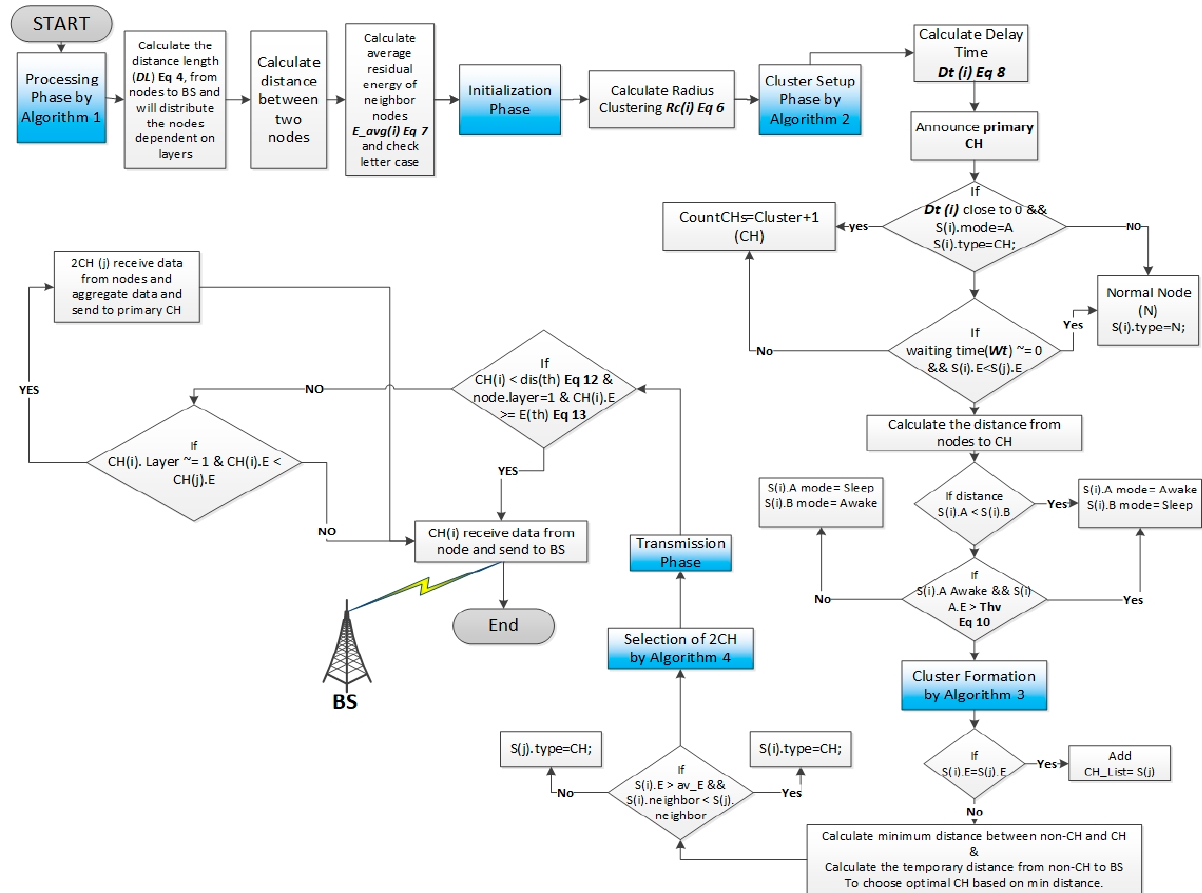
Figure 4. Flowchart of energy-efficient unequal clustering scheme based on a balanced energy method (EEUCB)